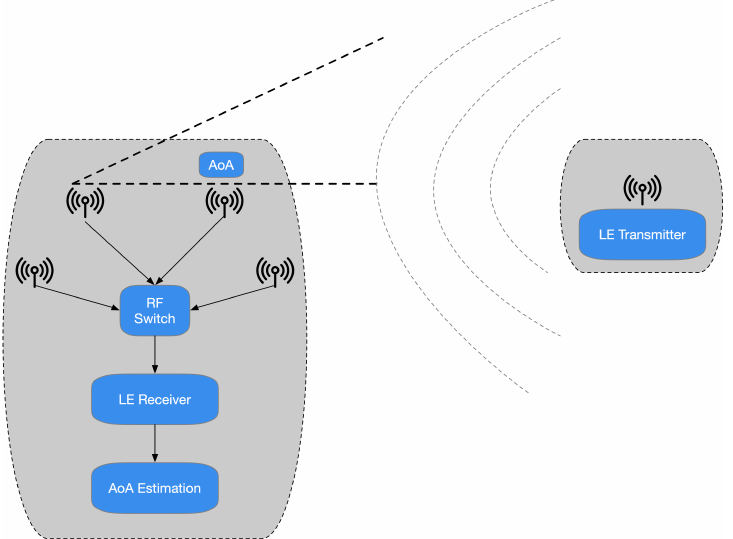
Figure 5. In an asset tracking system employing AoA radiogoniometry, the tag practices a unique antenna and a conventional BLE SoC to transmit Bluetooth 5.1 data, including the CTE. The principal calculations are then made at the locator of the system’s different antennas. Here, the locator’s signal data are sent to a locating scheme that operates the radiogoniometry